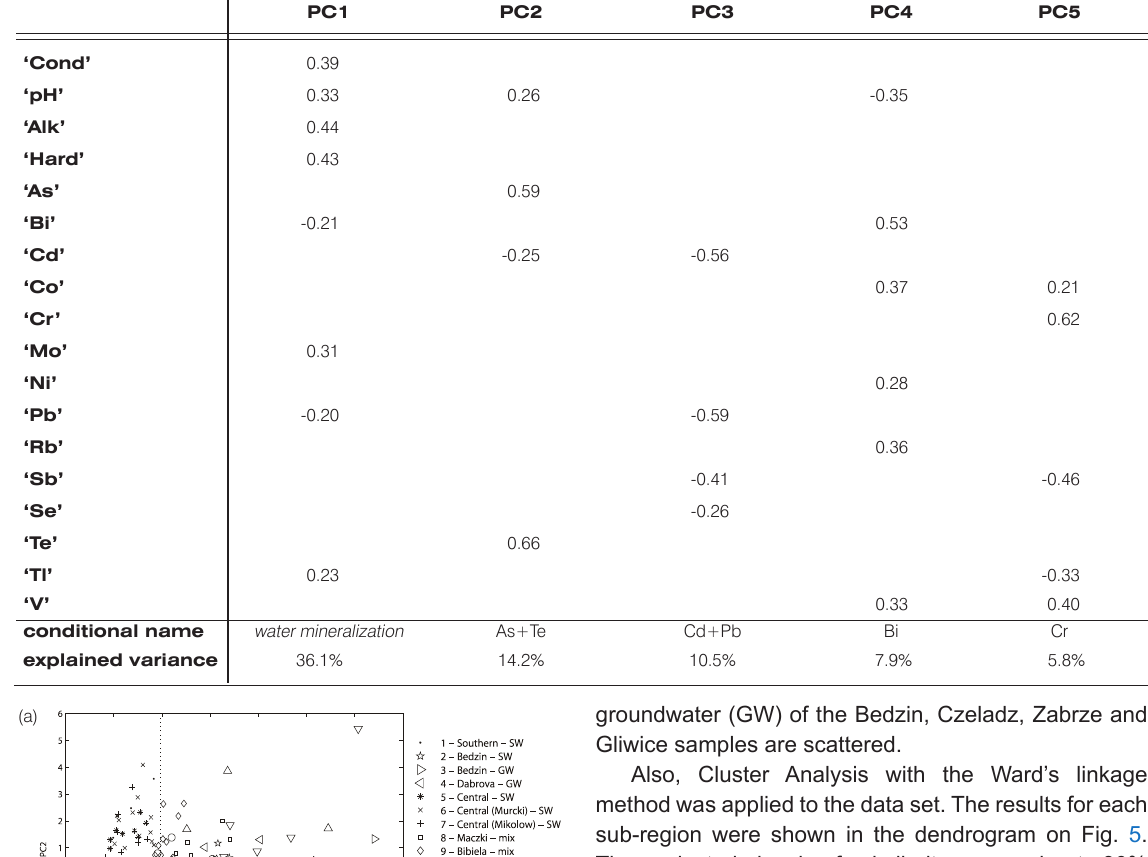
Table 10. Factor loadings (values below 0.20 were omitted).